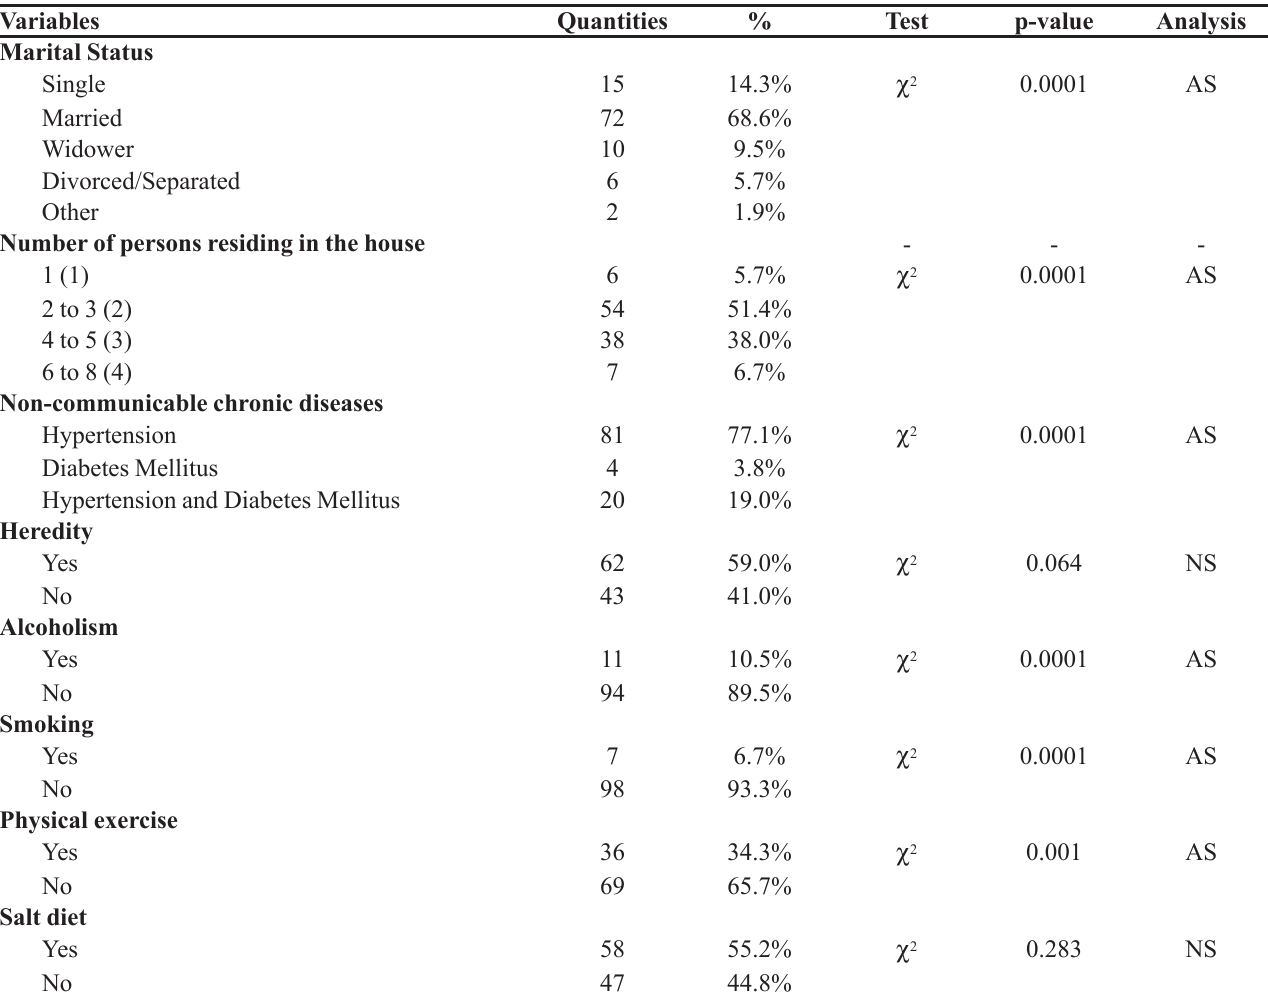
TABLE I - Distribution of sociodemographic and economic variables of Hiperdia users (Applying the Chi Square analysis of variables adherence) (cont.)